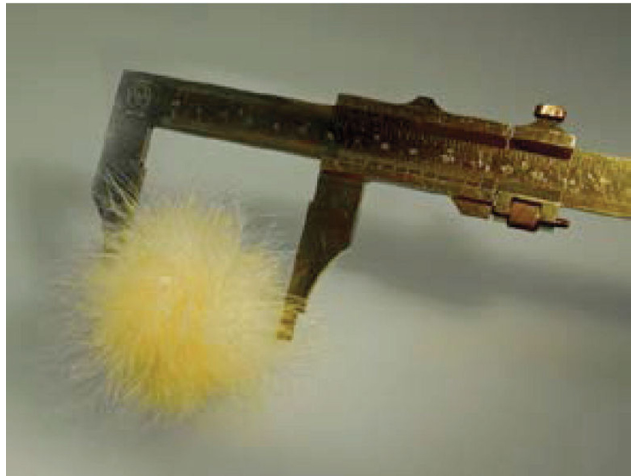
Fig. 7. Metaphorical illustration of “ soft metrology ” . Source: Laura Rossi, Inrim.